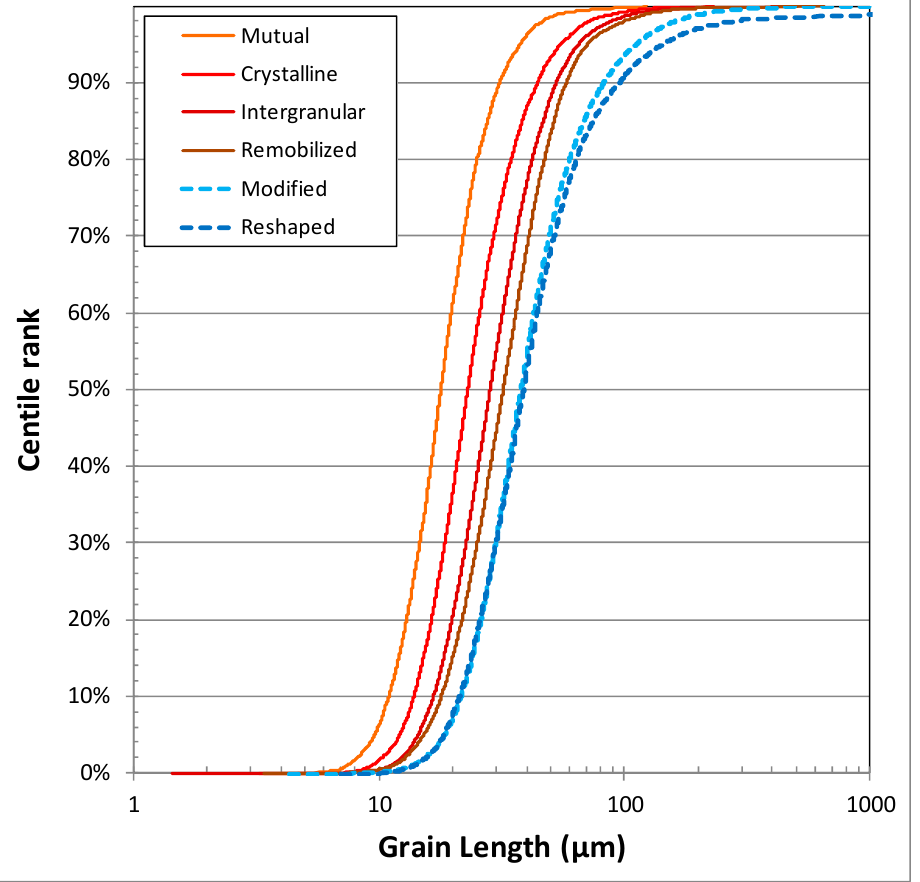
Figure 10. Size distribution of gold grains according to their shape. “Modified” and “Reshaped” grains are distinctively larger and skewed toward larger grains than the various type of “pristine,” which themselves have different average size. “Reshaped” grains are twice the size, on average, of “mutual” grains, these being smaller than what can be measured with a stereomicroscope.